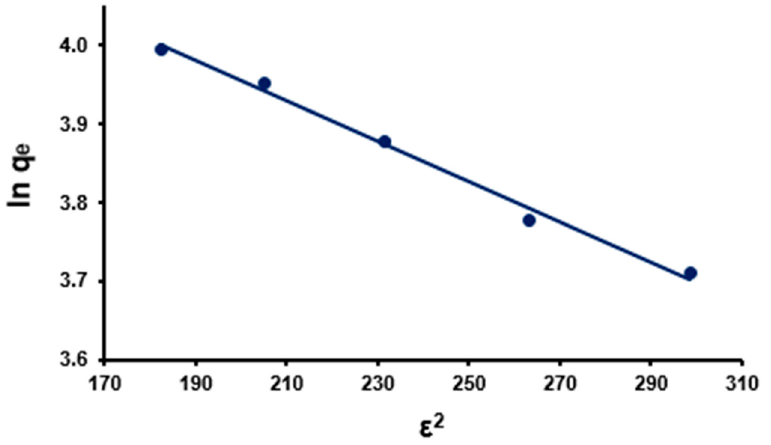
Figure 5. Dubinin–Radushkevich isotherm for niobium sorption with anionite Purolite A-100. The Dubinin–Radushkevich model indicates the nature of the adsorption of the